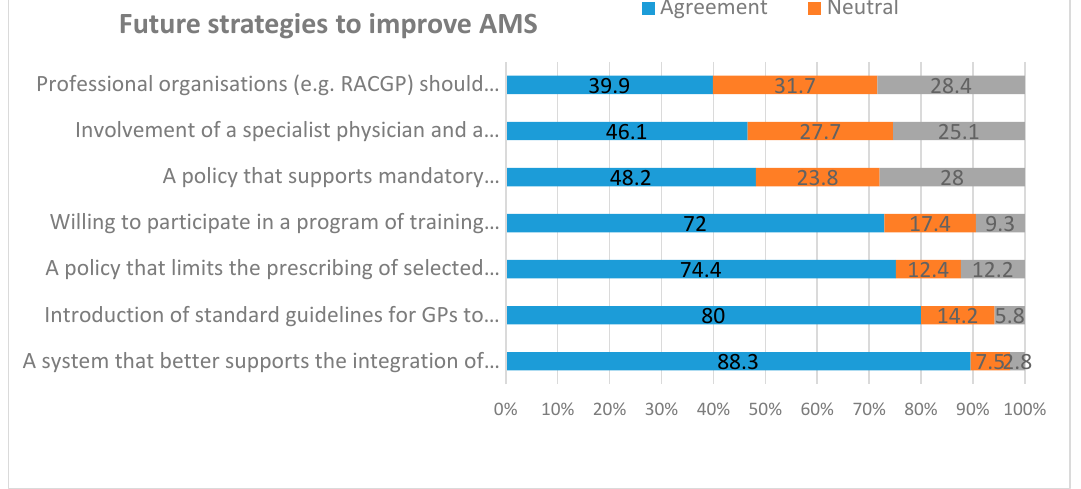
Figure 4. Proportion of GPs agreeing with future strategies to improve AMS in general practice. [RACGP, The Royal Australian College of General Practitioners].